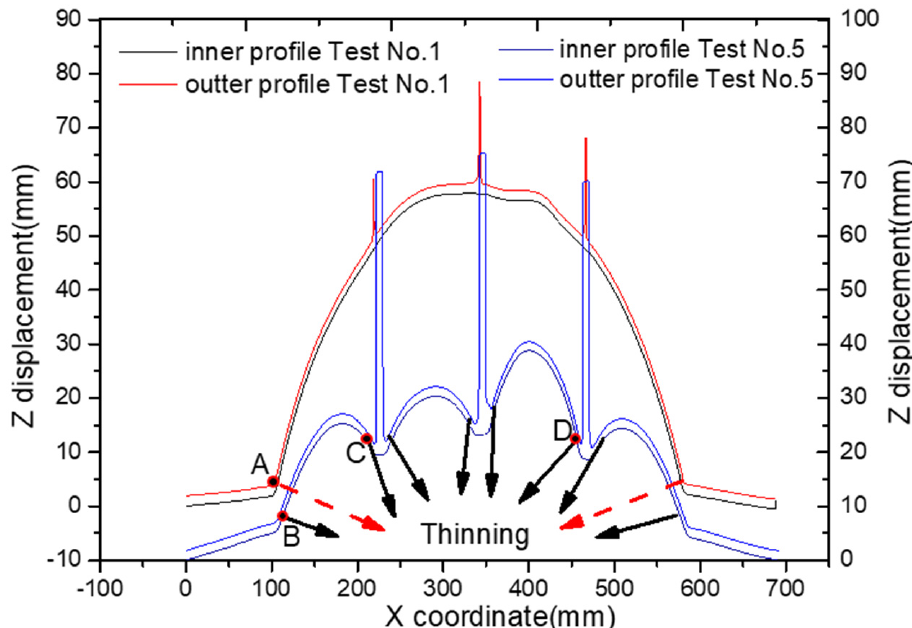
Figure 13) is specifically shown in Figure 14. In Figure 14, the dashed line is the section profile, and the solid circle is the imaginary plate thickness. When the point in the section profile is distributed in the circle, this means that the plate thickness in this specific point decreased; namely, plate thinning occurred. Figures 13 and 14 show that when stiffened plate deforms in Mode Ia, plate thinning just appears at the boundary. While thinning of the plate was not only observed at the boundary, but also around the two sides of the stiffeners when the stiffened plate deformed in Mode Ib. A similar phenomenon was also presented in the double stiffened plate in the work of [13], where stiffened plate was subjected to open- air explosion. However, they stressed that thinning occurred only at the side of the stiffener closest to the boundary, which is different from our experimental observation in Test No. 5. It is inferred that the strong restriction on the stiff stiffeners increased the supporting effect of the stiffeners to the plate. Namely, the stiffeners performed as boundary supports for the small plates. Hence, all the “small” plates divided by the stiffeners deformed greatly and thinning around all the “boundaries” was observed.